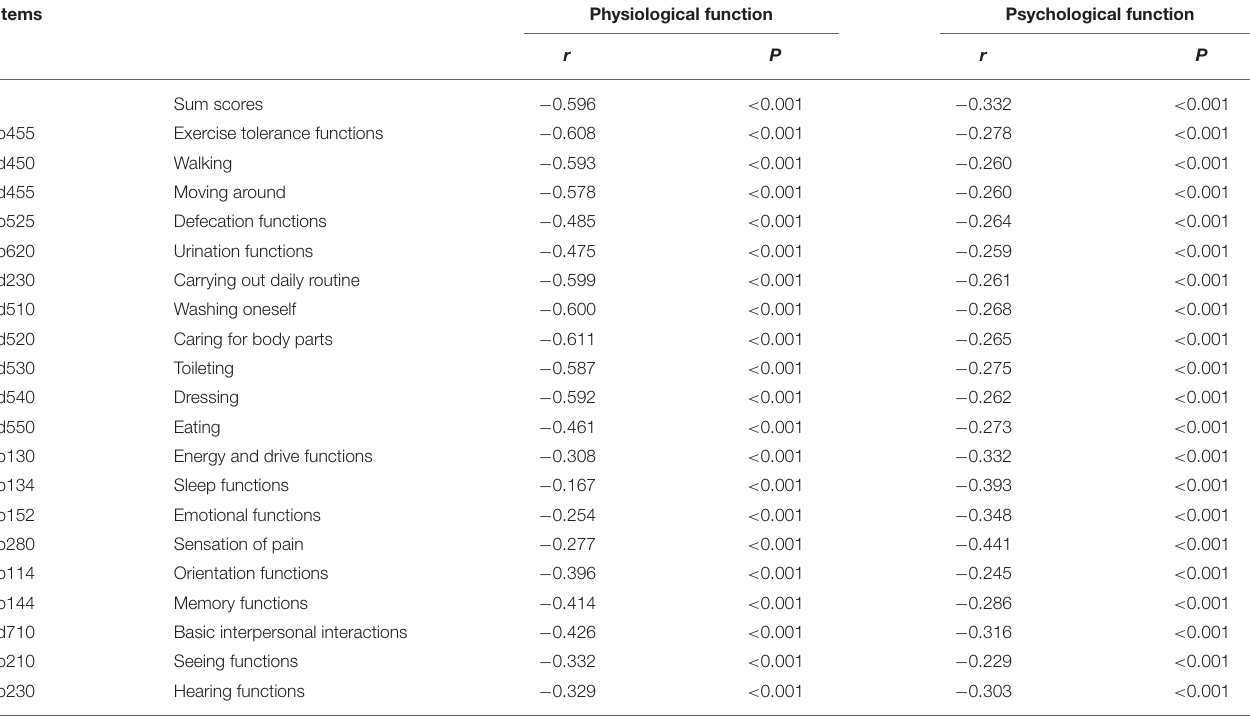
TABLE 5 | Criterion-related validity of ICF disability assessing scale ( n = 1,610).